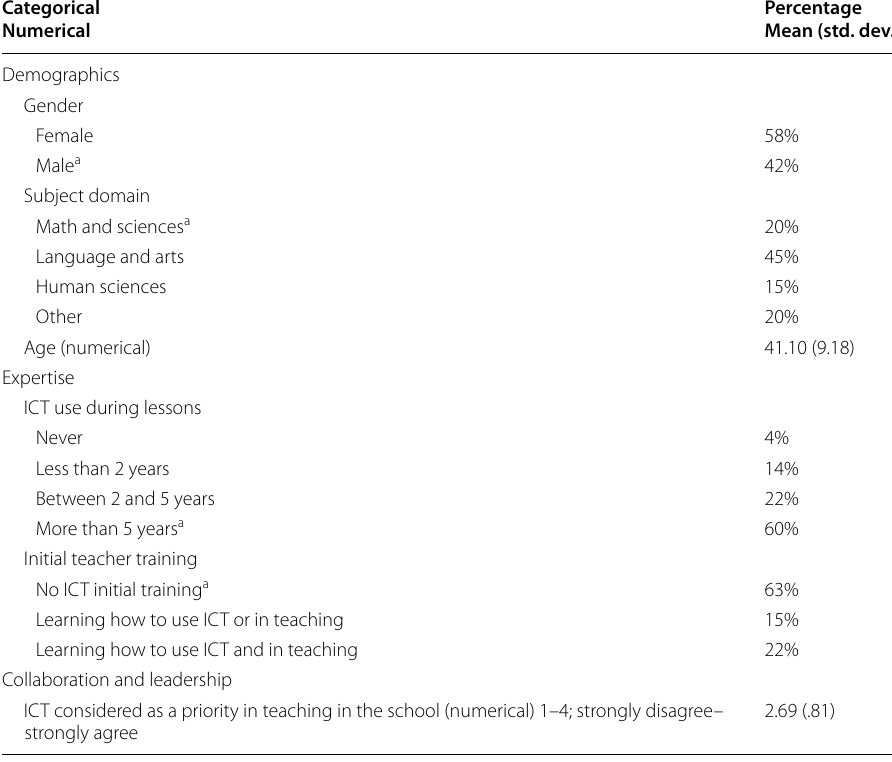
N 420 teachers; alternative weighting approach = a Baseline category for the regression analysis